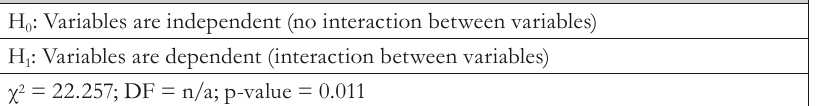
Tab. 8 - Q2b Chi-squared Test and p-value. Source: authors Pearson’s Chi-squared test with simulated p-value (based on 5000 replicates) H : Variables are independent (no interaction between 0